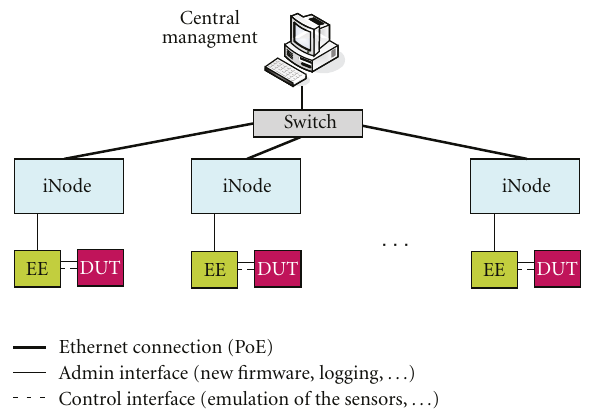
Figure 4: iLab.t WiLab testbed architecture. The central man- agement server has an ethernet connection with all the iNodes. These iNodes provide an admin interface to the environment emulator (EE), which provides both an admin interface and a control interface to the device under test (DUT).